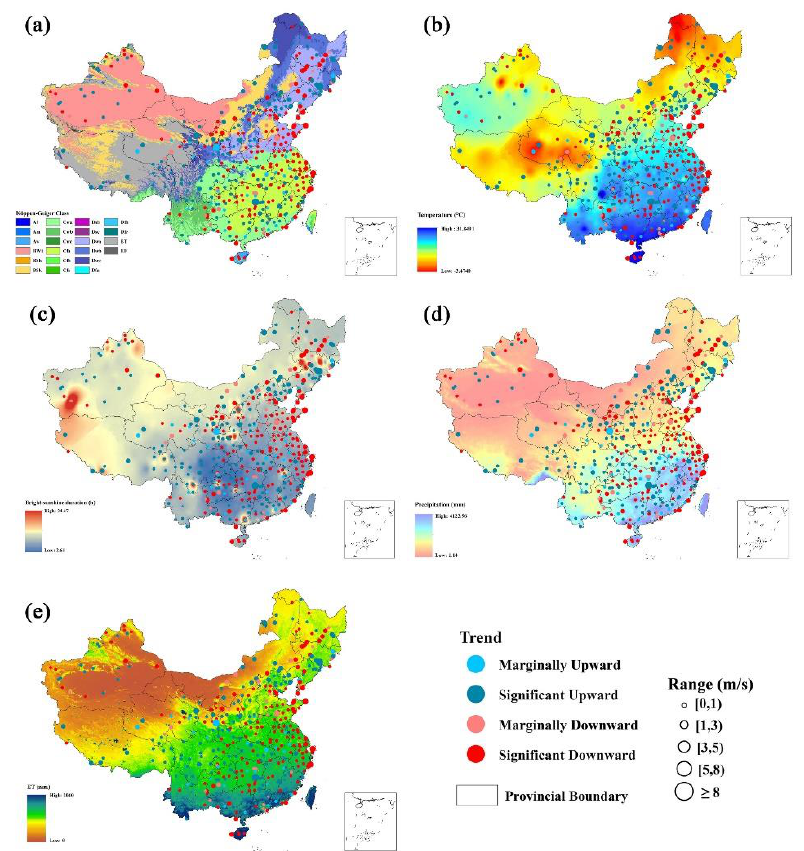
Figure 13. Spatial distribution of different wind speed ranges of China, from 2000 to 2019, for: ( a ) for: ( a ) Köppen–Geiger climate classification [65]; ( b ) temperature; ( c ) bright sunshine duration; Köppen–Geiger climate classification [65 ]; ( b ) temperature; ( c ) bright sunshine duration; ( d ) precip- itation; ( e ) evaporation. ( d ) precipitation; ( e )